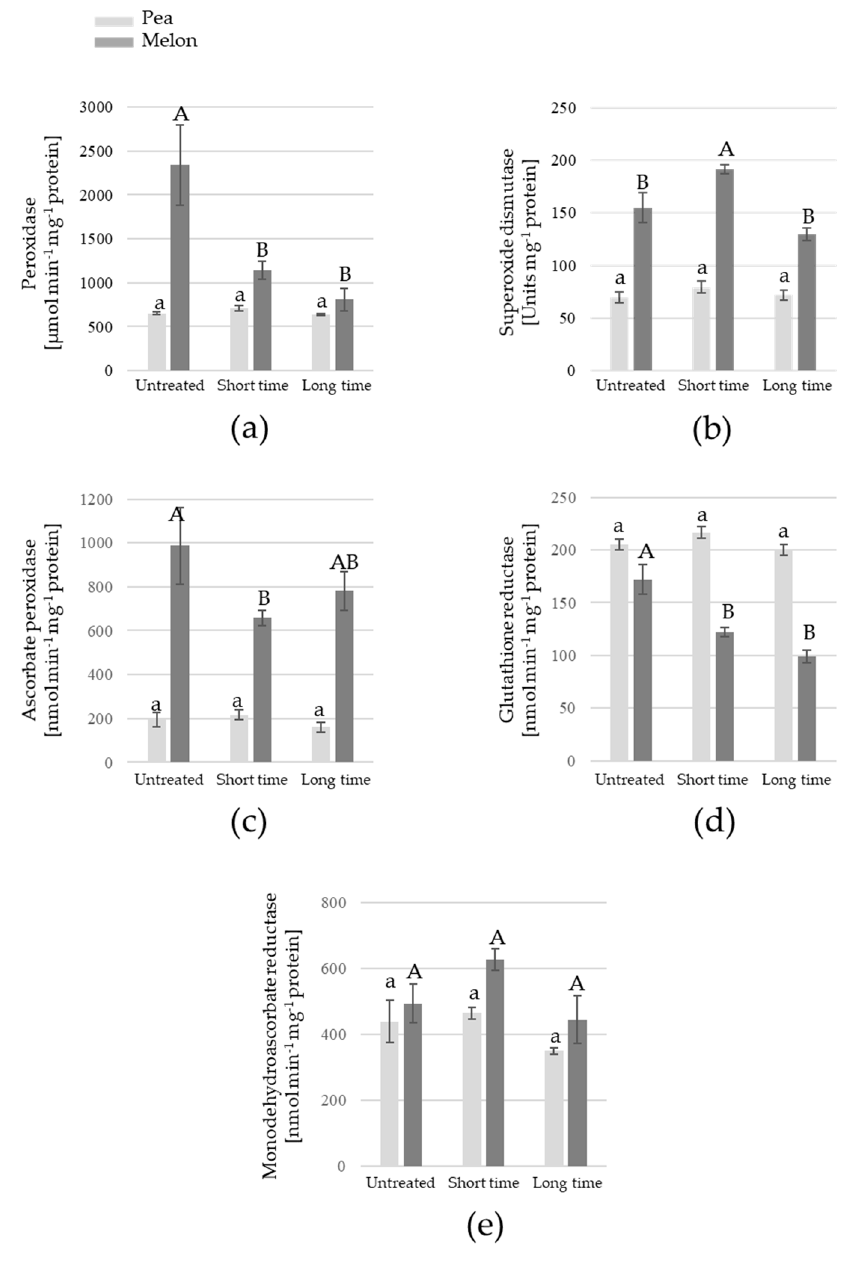
Figure 7. Activity of peroxidase ( a ), superoxide dismutase ( b ), ascorbate peroxidase ( c ), glutathione reductase ( d ) and monodehydroascorbate reductase ( e ) on samples of untreated, 15-min red light-treated (short time), and 30- and 60-min red light-treated seedlings (long time) for melon and pea, respectively. Data represent the mean ± SE from 3 biological replicates, each one comprising all seedlings of a Petri dish. Different letters (small letters for pea and capital letters for melon) indicate significant differences according to Tukey ′ s test ( p ≤ 0.05).